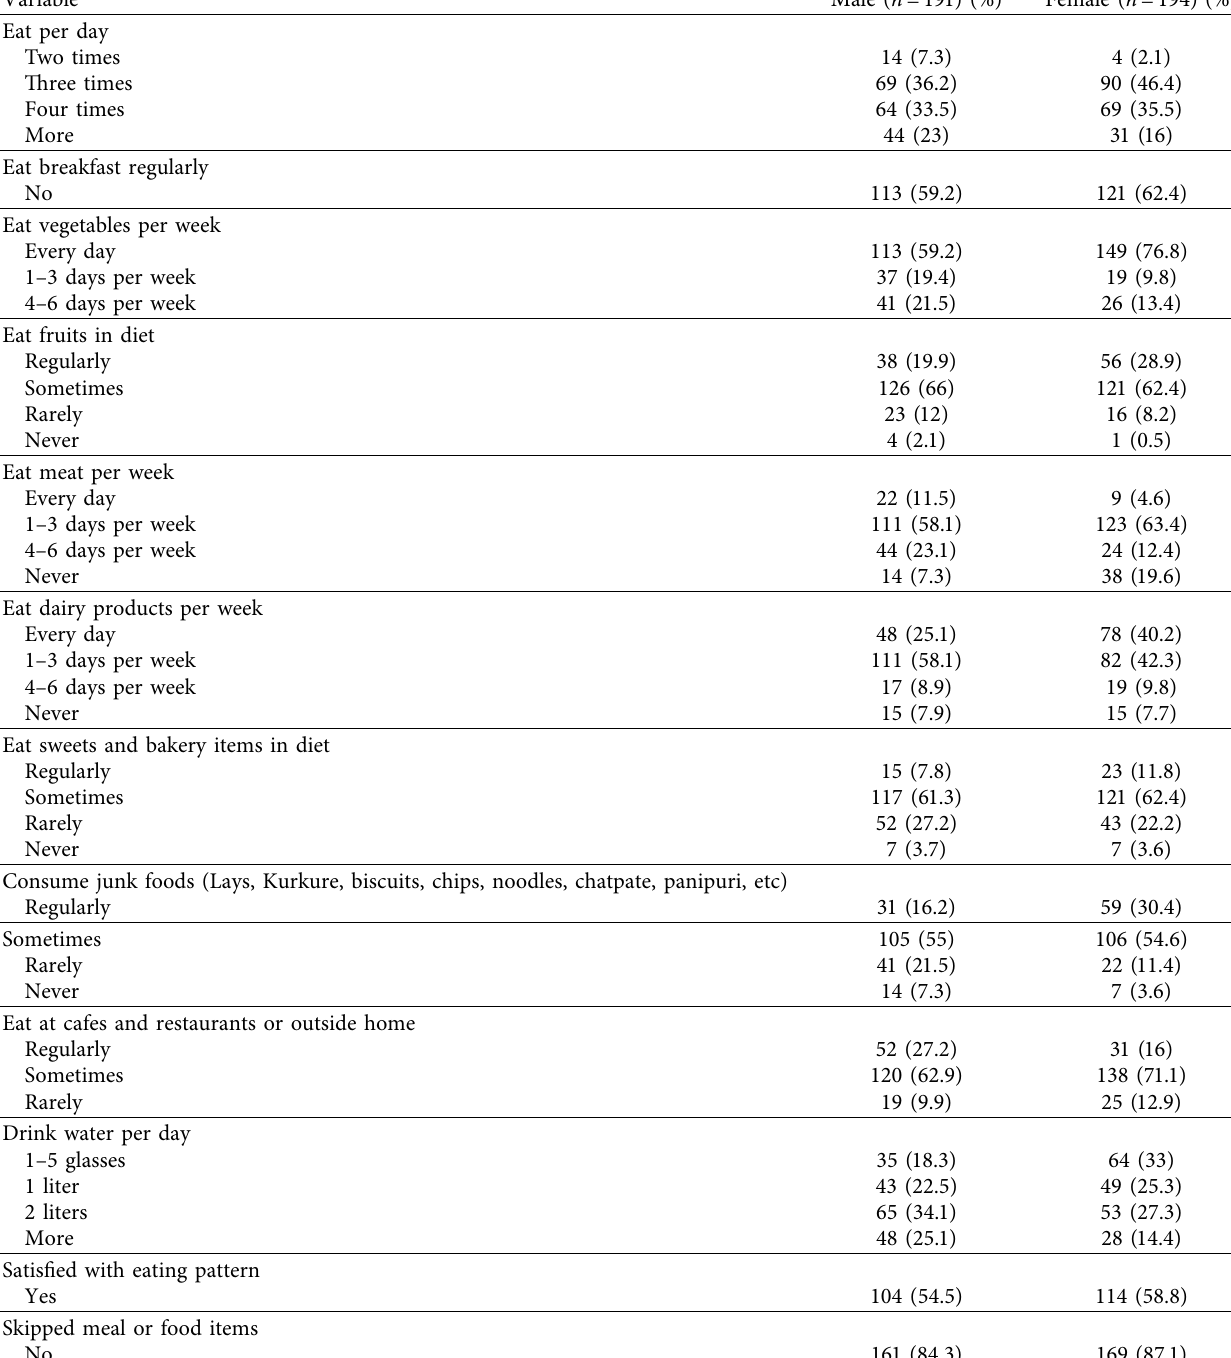
Table 2: Eating practice of respondents ( n �